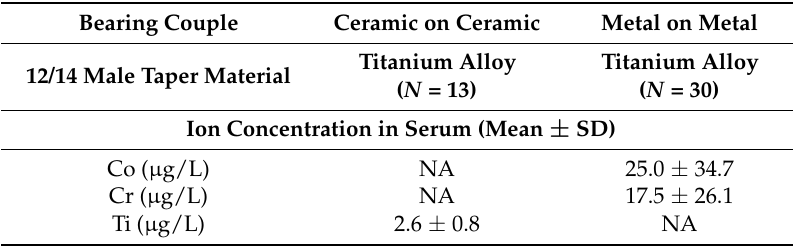
Table 5. Ion concentration in serum determined for each group. Sample size N is reported for each group.